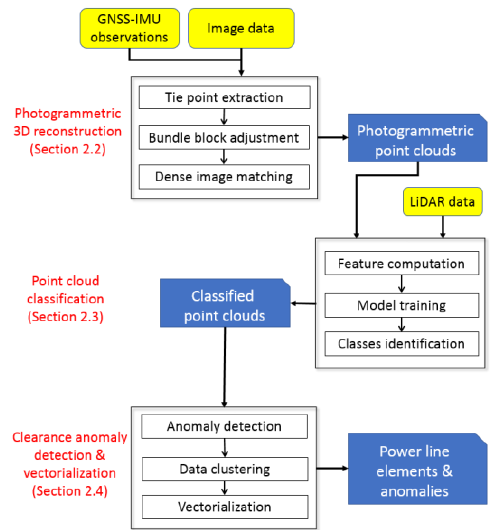
Figure 2. The general workflow of power line mapping (yellow cells are the raw input data, blue cells are the